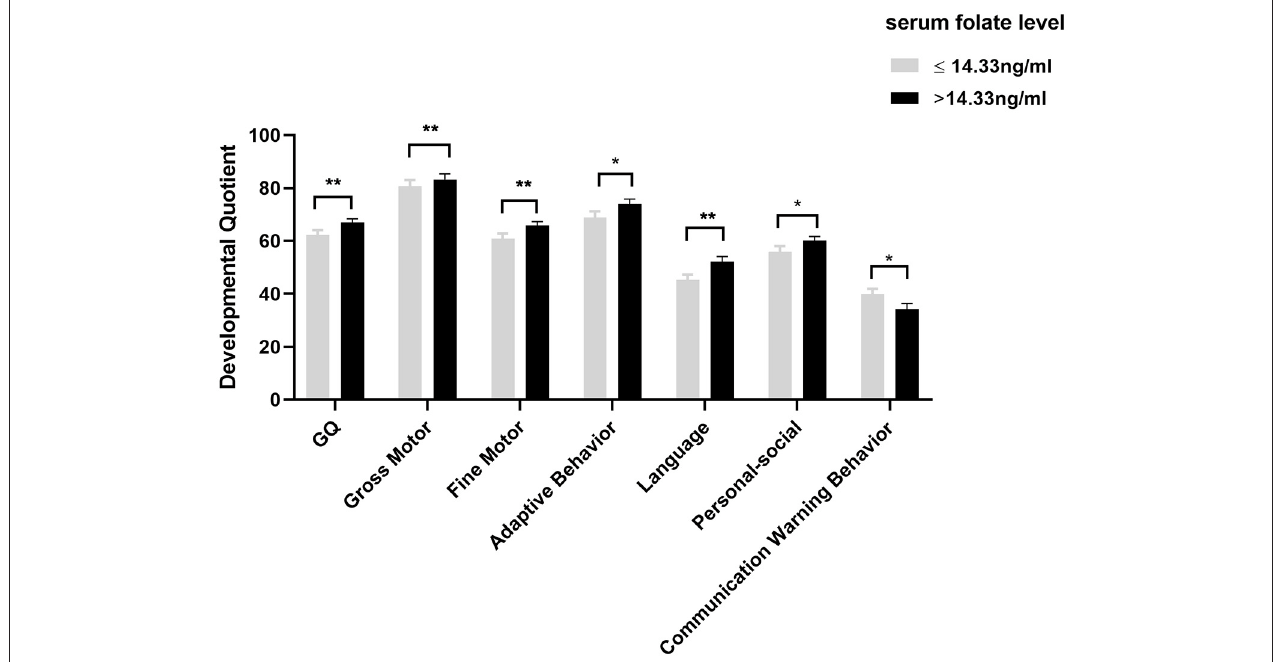
FIGURE 4 | Comparison of CNBS-R2016 scores at different serum folate levels in ASD children aged three and under. Data was presented as mean ± SEM. The Mann-Whitney test and the two-tailed Student’s t -test were used for the comparison. * P < 0.05, ** P <